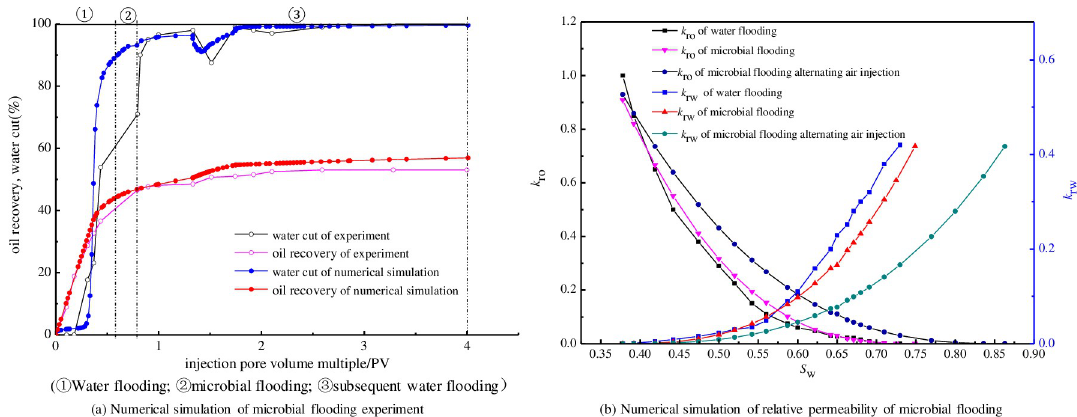
Fig 11. Numerical simulation of oil recovery and relative permeability of microbial